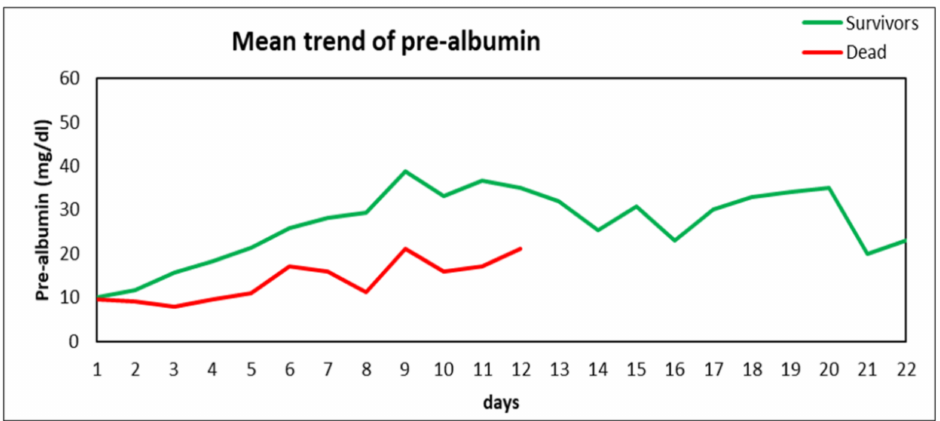
Figure 1. Mean serum pre-albumin levels trend of survivors and non-survivors during days of ICU stay ( p < 0.05).